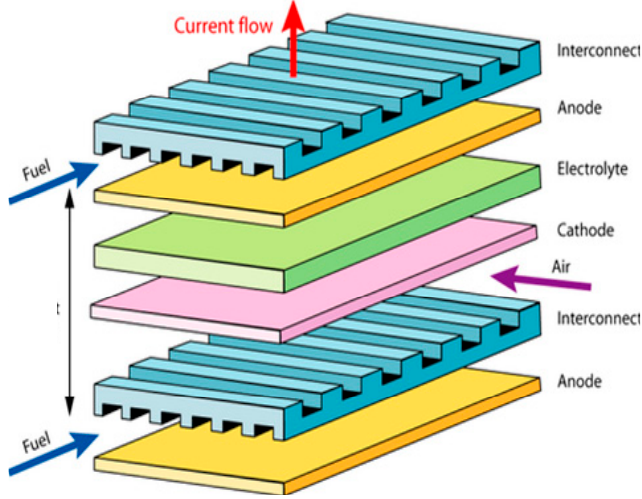
Figure 3. SOFC stack composition structure.